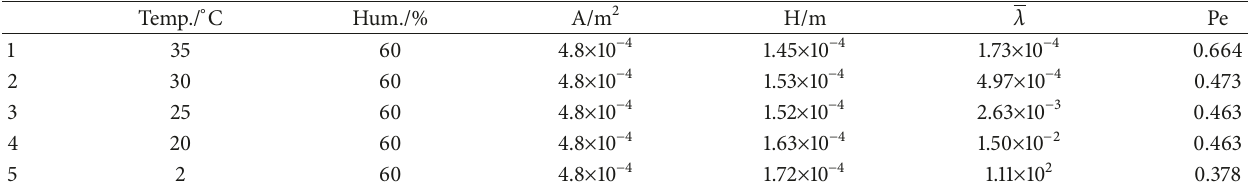
Table 3: The Russell-Routh model parameters ∗ for the water-borne copolymer particles. Temp./ ∘ C